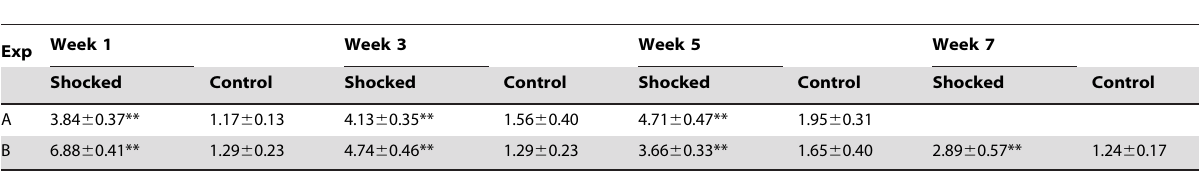
Table 3. Average time of freezing (sec) out of 10 sec test periods in the freeze test.